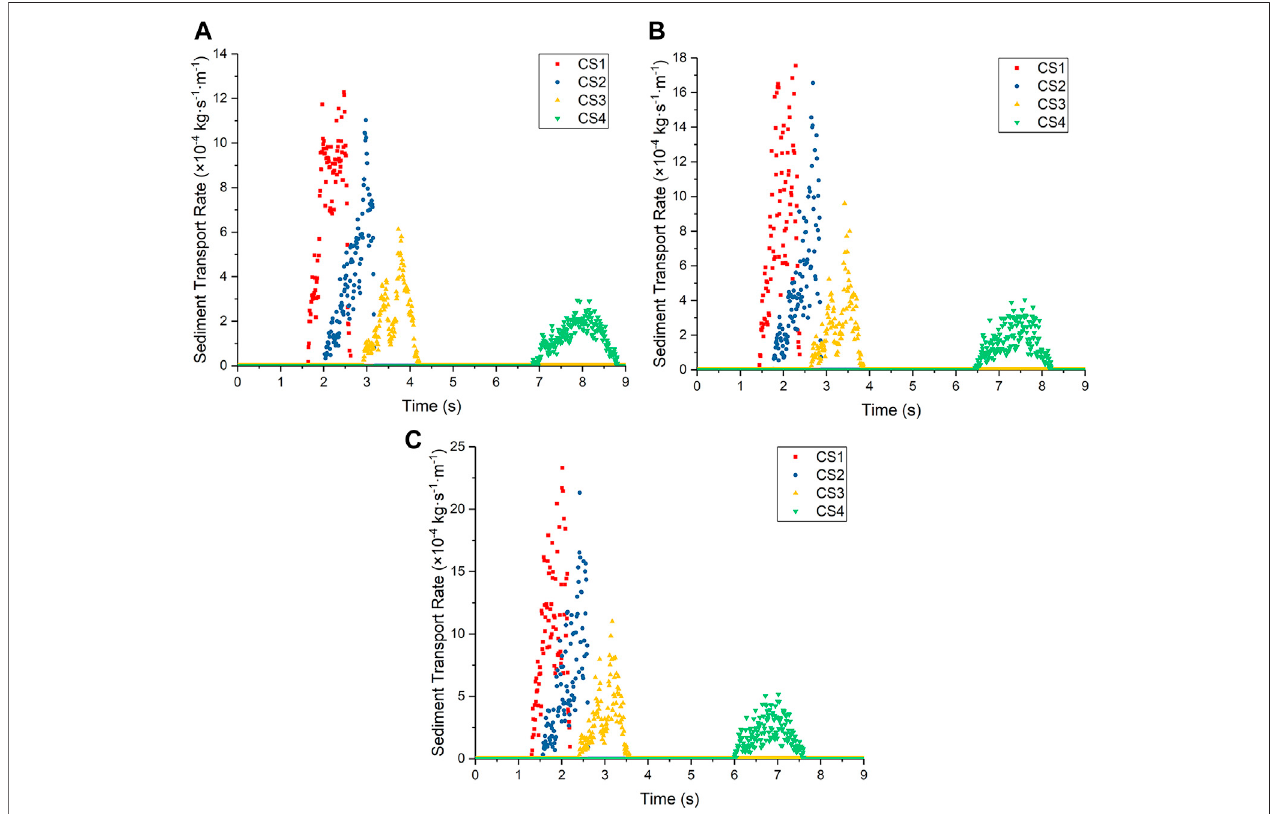
FIGURE 10 | Sediment transport, gravity erosion: (A) adjustable gully slope: 5 ° ; (B) adjustable gully slope: 15 ° ; (C) adjustable gully slope: 30 ° .